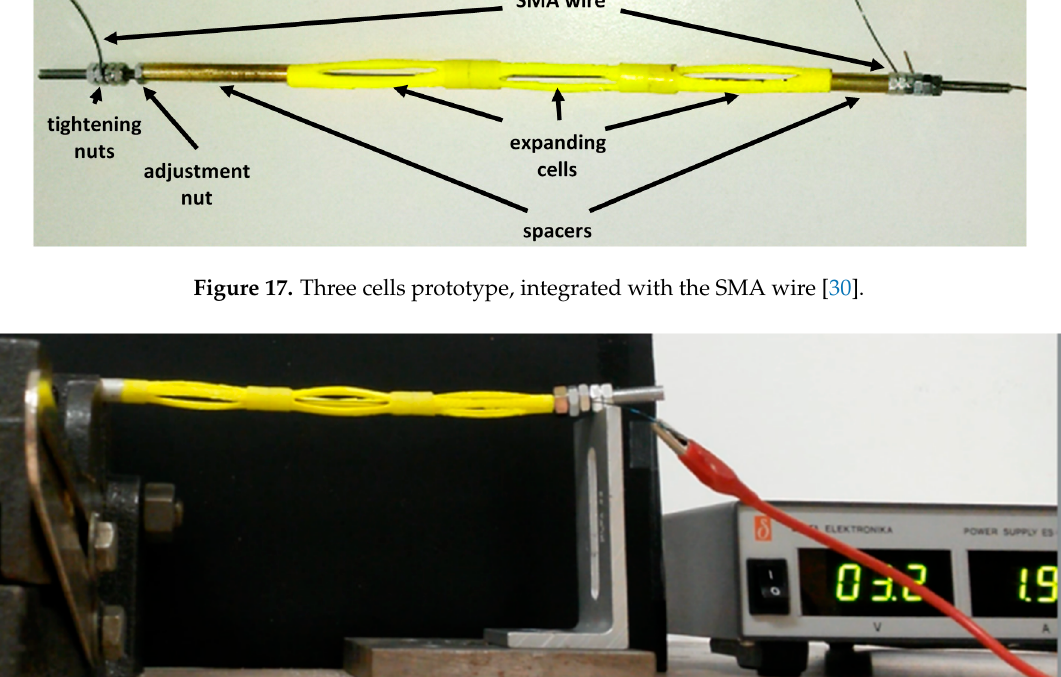
Figure 16. Digital mockup of a 3-cell cluster, integrated with an SMA wire: global view ( top ); detail of the terminal ( bottom ) with a further magnification on the connection segment ( bottom, top right ).